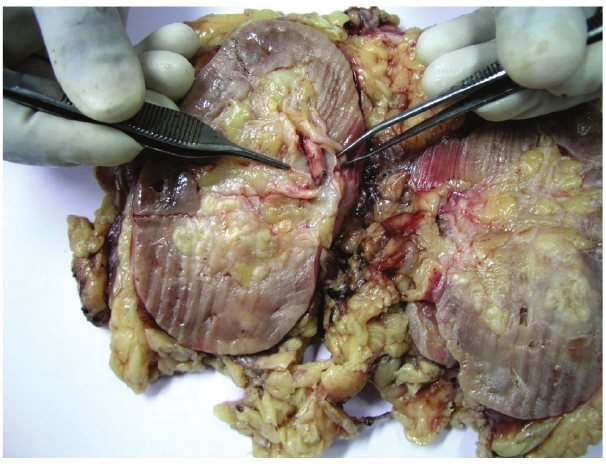
Figure 2. Gross specimen showing thrombus in renal vein. Figure 3. Microscopic examination at 100X magnification showing collection of foamy macrophages and inflammatory infiltrate diffusely infiltrating the renal